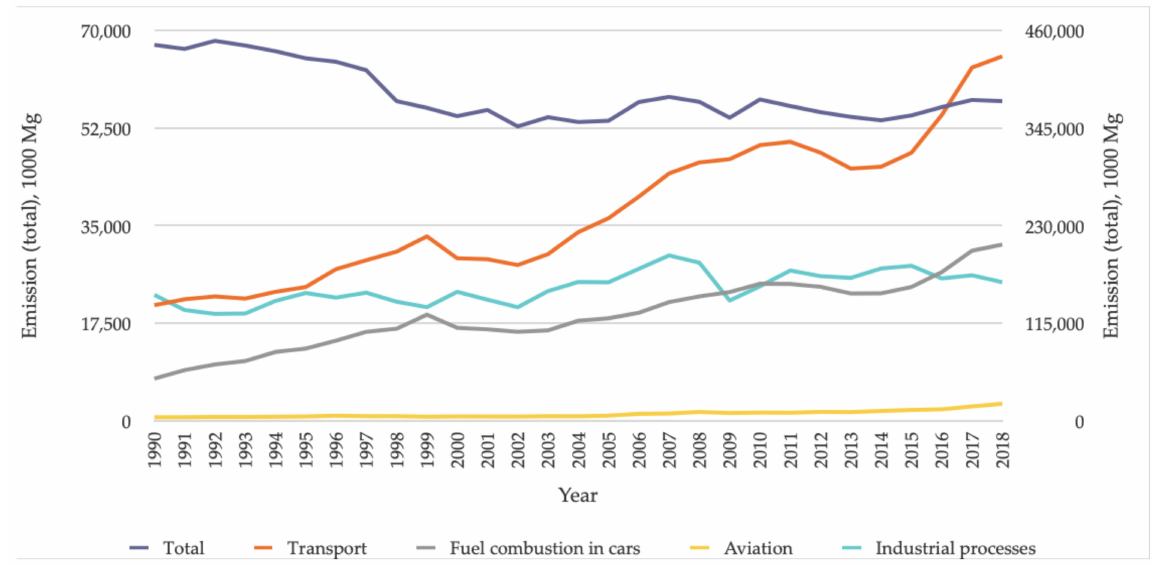
Figure 1. Gaseous air pollutant emissions in Poland. Based on data from Eurostat, European Environment Agency (EEA)